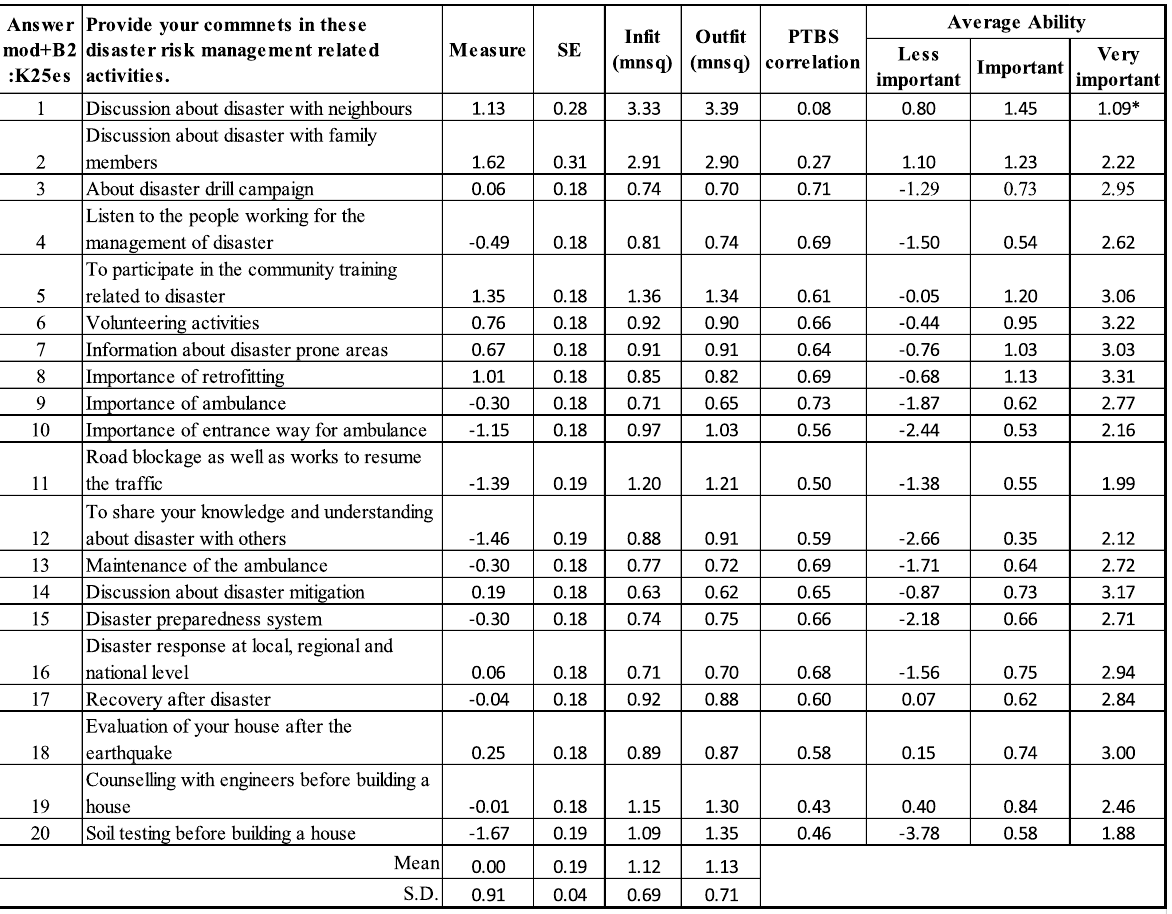
management related